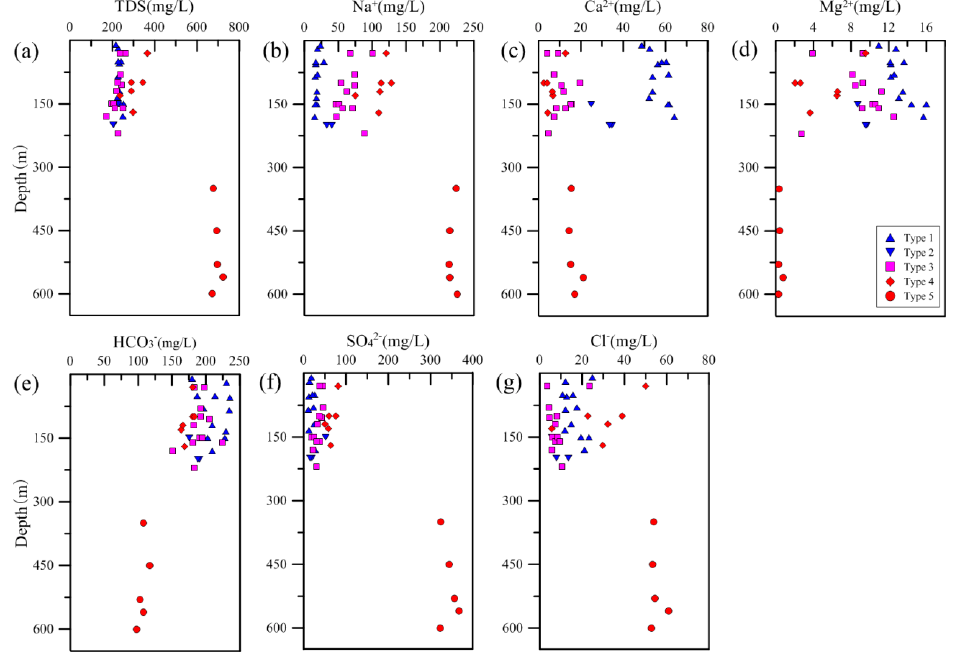
Figure 5. The plots of the chemical compositions of groundwater versus sampling depth: ( a ) TDS content; ( b ) Na + content; ( c ) Ca 2 + content; ( d ) Mg 2 + content; ( e ) HCO 3 − content; ( f ) SO 42 − content; and ( g ) Cl − content of groundwater.